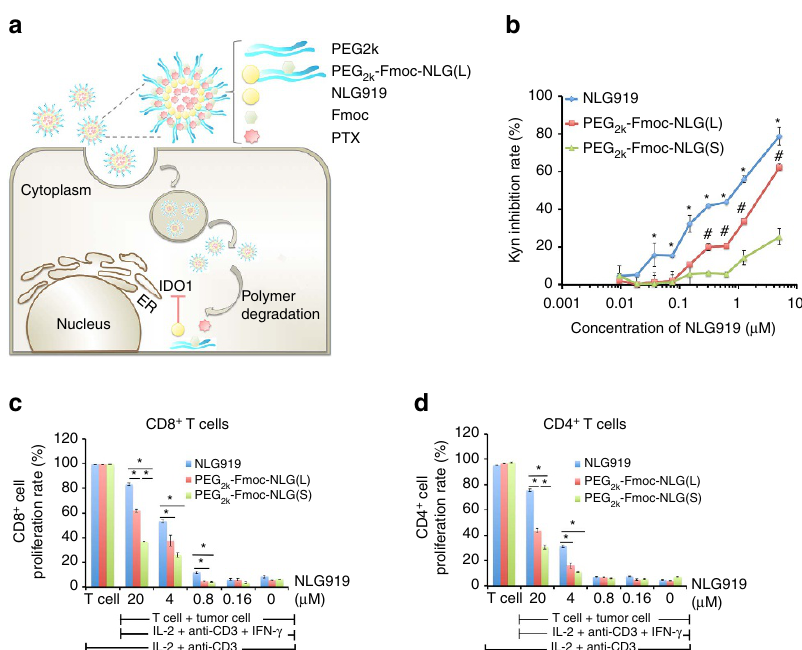
Figure 1 | In vitro biological activities of PEG 2k -Fmoc-NLG. ( a ) Schematic representation of self-assembled PTX/PEG 2k -Fmoc-NLG mixed micelles. ( b ) PEG 2k -Fmoc-NLG inhibited IDO enzyme activity in vitro . HeLa cells were treated with IFN- g together with free NLG919 or PEG-NLG conjugate. Kynurenine in supernatants was measured 2 days later. Data represent means ± s.e.m. * P o 0.05 (versus PEG 2k -Fmoc-NLG(L), N ¼ 3), # P o 0.05 (versus PEG 2k -Fmoc-NLG(S), N ¼ 3). ( c , d ) IDO1 inhibition reversed T-cell suppression mediated by IDO-expressing mouse pancreatic cancer cells (Panc02). Panc02 cells and splenocytes were mixed and treated with IL-2, anti-CD3 antibody, IFN- g together with NLG919 or PEG-NLG conjugate for 3 days. ( c ) CD4 þ and ( d ) CD8 þ T-cell proliferation was examined by FACS analysis. Representative data of three independent experiments are presented as means ± s.e.m. * P o